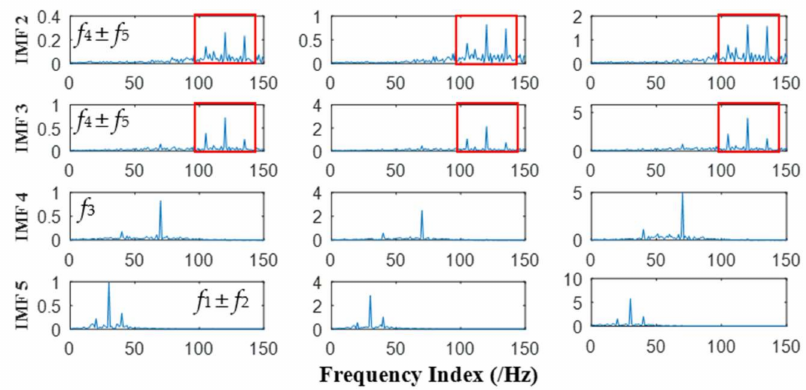
Figure 10. Frequency domain plots of effective IMFs of MEMD.